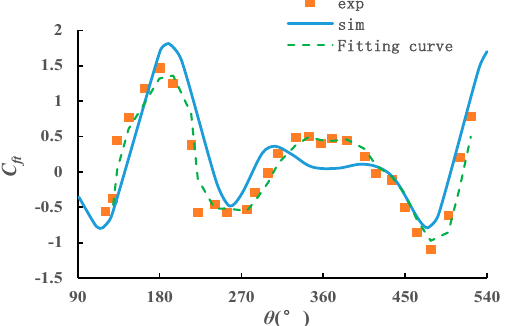
Figure 11. Comparison of tangential force coefficient between numerical simulation results and experimental results in the literature.